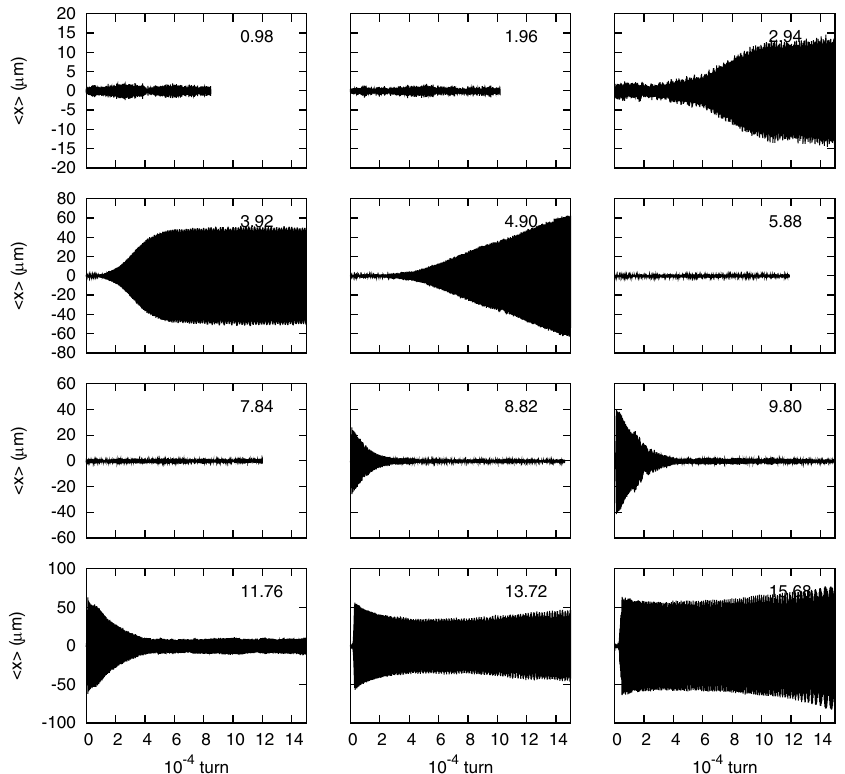
(cid:3) (cid:7) (cid:1) 0 : 51 ; 0 : 57 (cid:3) . The corresponding bunch current (unit: ; 7 x y (cid:7) 4 : 90 mA . b